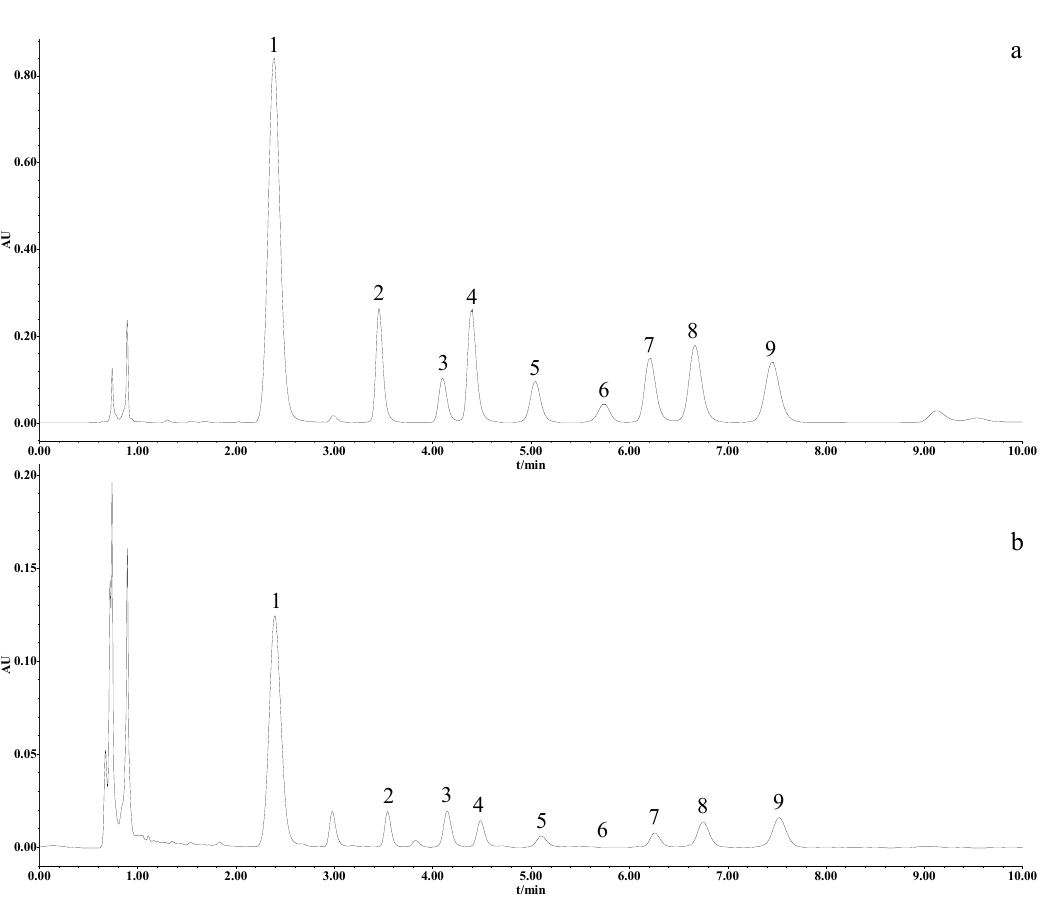
Table 3. Eight monosaccharides contents in processed velvet antler ， expressed per mg/kg ( ± SD, n = 3).